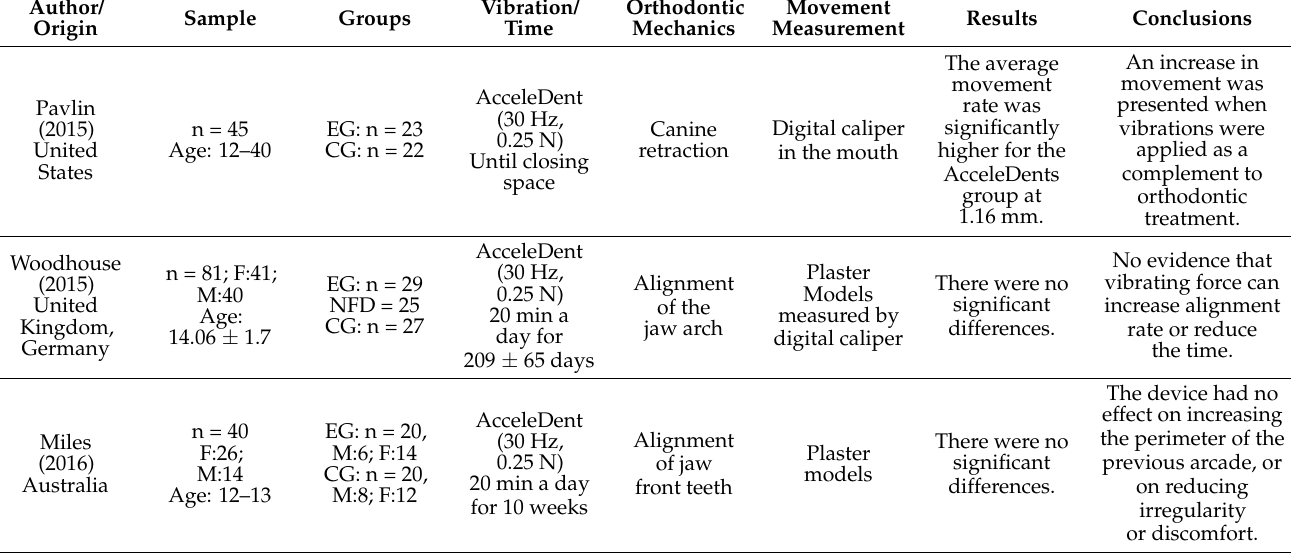
Table 1. Summary of characteristics of the low-frequency vibration articles.